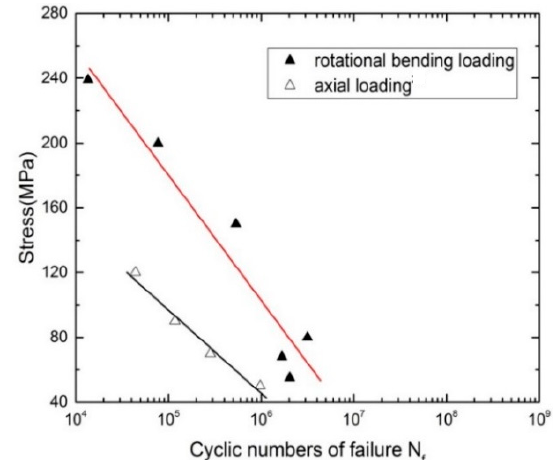
Figure 5. The S ‐ N curves of AA2024 ‐ CZ under the different cyclic loading styles at 3.5 wt. % NaCl Figure 5. The S-N curves of AA2024-CZ under the different cyclic loading styles at 3.5 wt. % NaCl aqueous solution, all data of mark ∆ come from literature [21]. aqueous solution, all data of mark ∆ come from literature